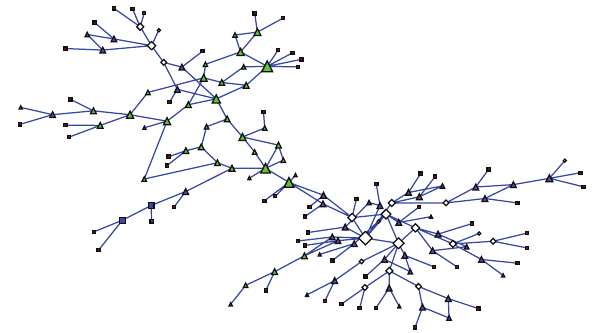
Figure 5: Topology layout of NX Grid.